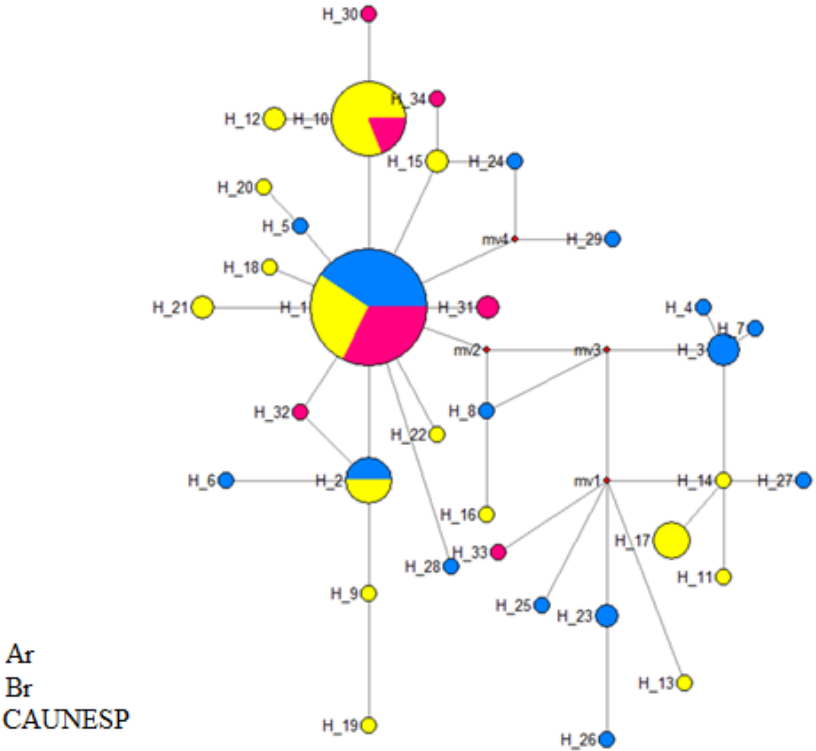
Figure 1 – Network of haplotypes in relation to haplotype flow among fish farms. The size of the circle is proportional to the haplotype frequency. Ar is fish farms from Argentina, Br is fish farms from Brazil, and CAUNESP from the breeding